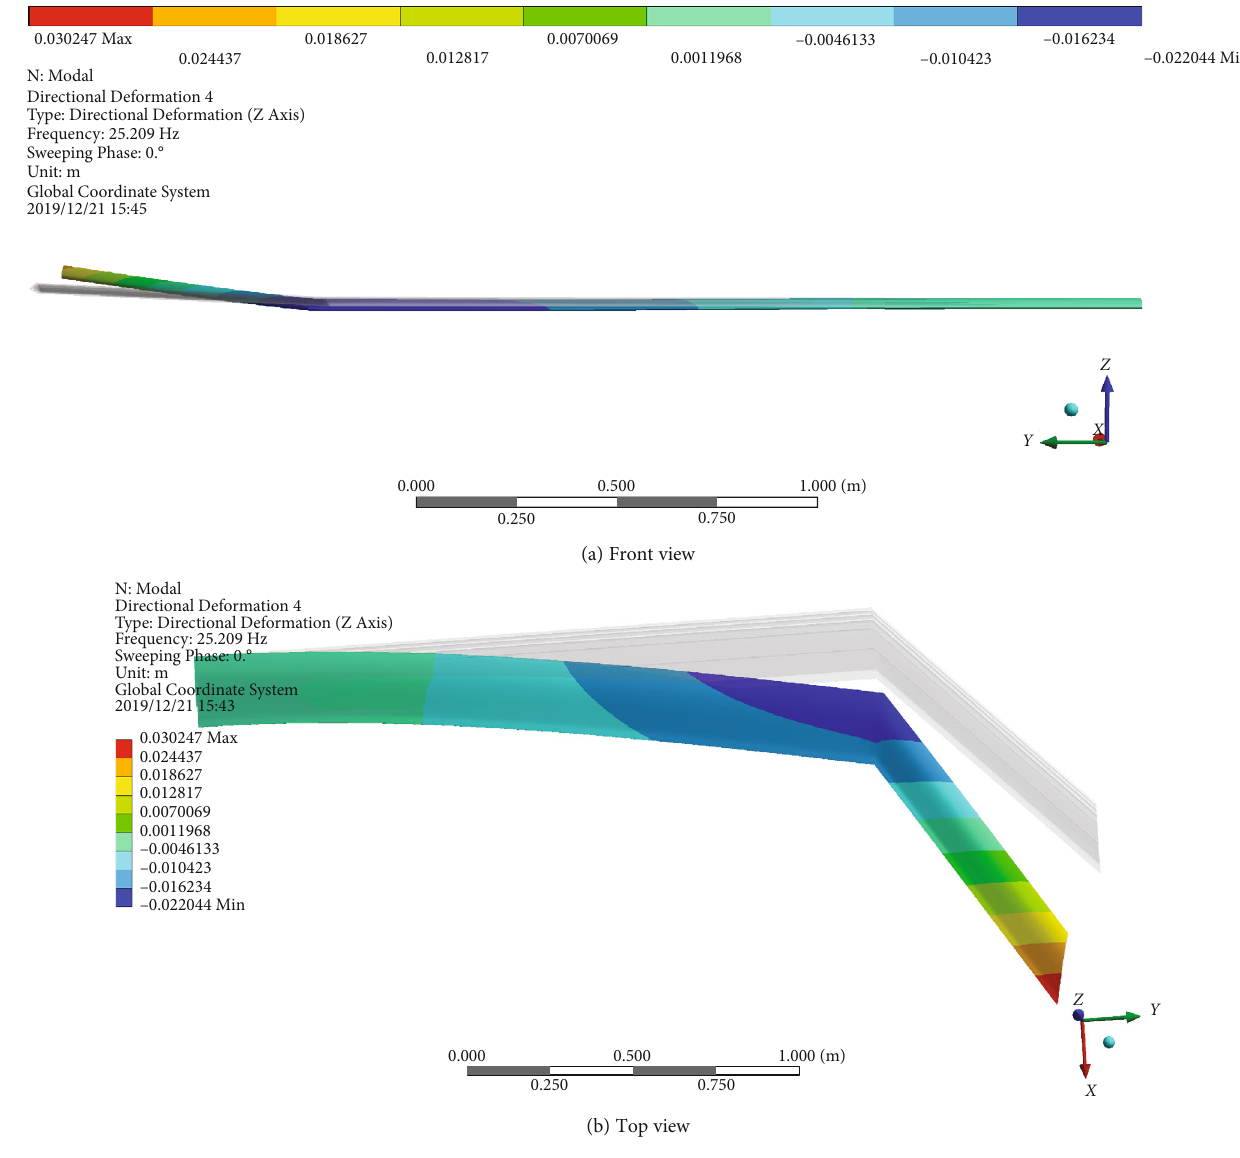
Figure 14: Lead-lag/torsion coupled